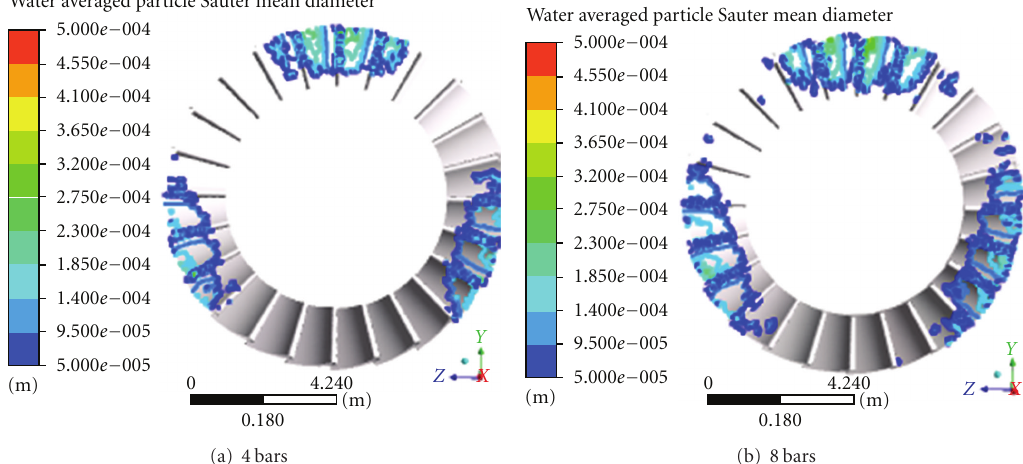
Figure 2: Numerical predicted water droplet size and its distributions on the blade surface at a loading speed of 800 rpm/T ∧ 0.5 and 30 ◦ water nozzle angle.